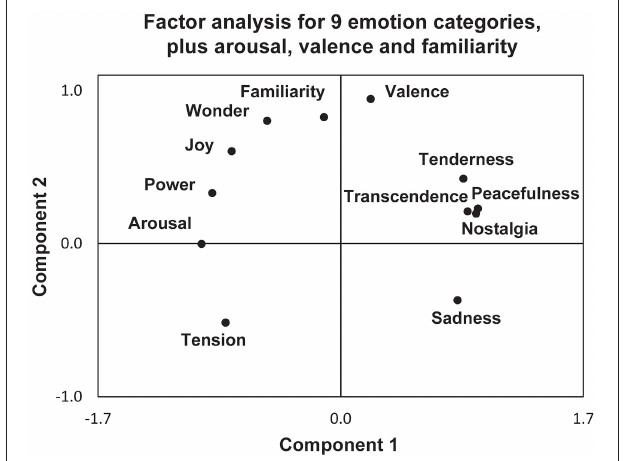
FIGURE 3 | A factorial analysis of emotional ratings after listening to different pieces of music, including the nine emotional categories of the Geneva Emotional Music Scale (GEMS) model (Zentner et al., 2008), together with familiarity, arousal and valence, reprinted with permission from Trost et al. (2012). The results show two main components, arousal ( component 1 ) and valence ( component 2 ), that best describe these behavioral data in 31